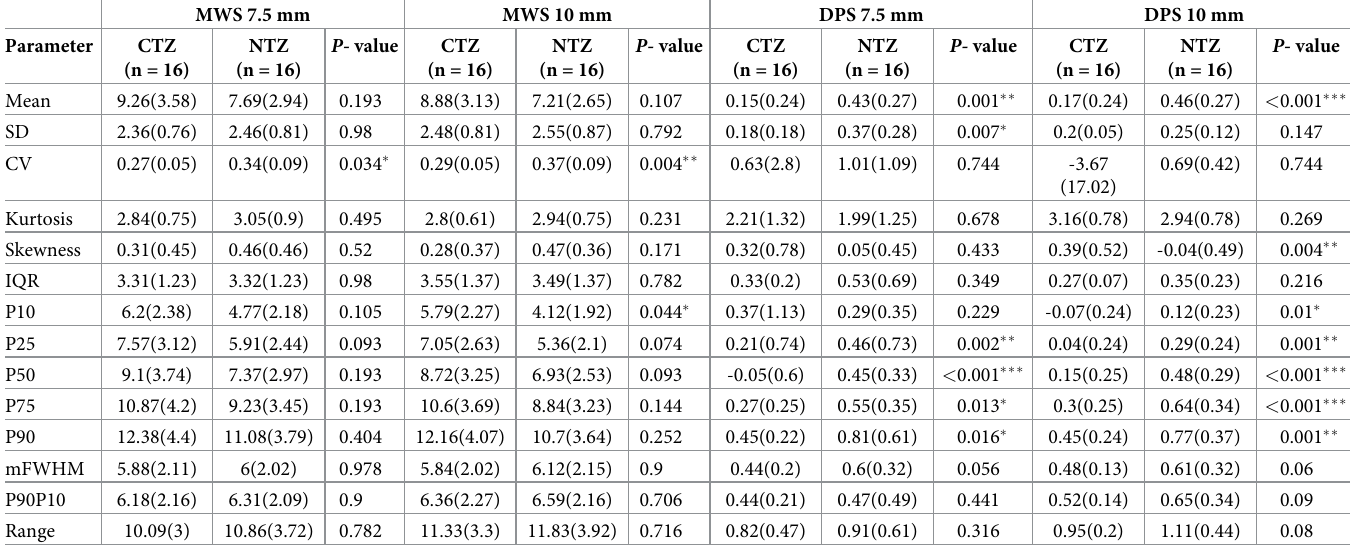
Table 2. Differences in the MWS and DPS histogram parameters between CTZ and NTZ with different diameters of the